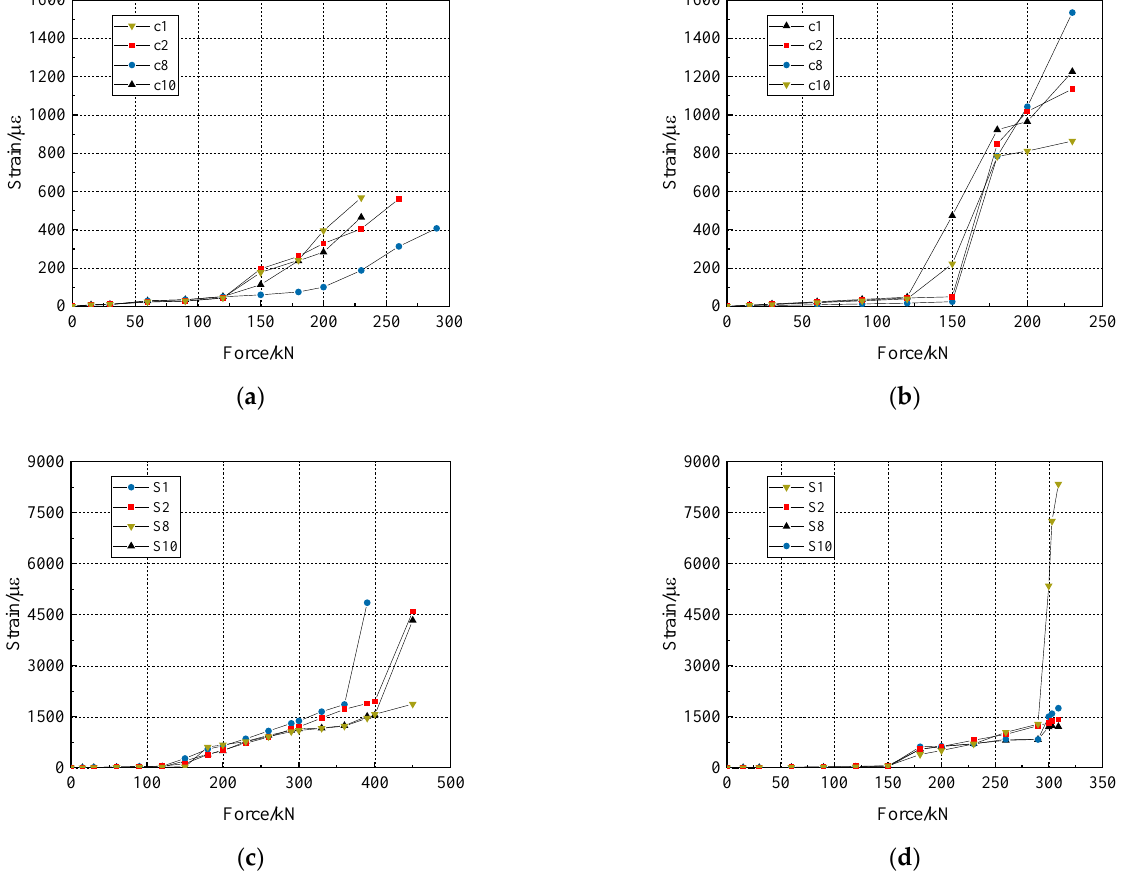
Figure 8. Load-strain curve. ( a ) Concrete of ordinary specimen. ( b ) Concrete of the hollow specimen. ( c ) Reinforcement of the ordinary specimen. ( d ) Reinforcement of the hollow specimen.